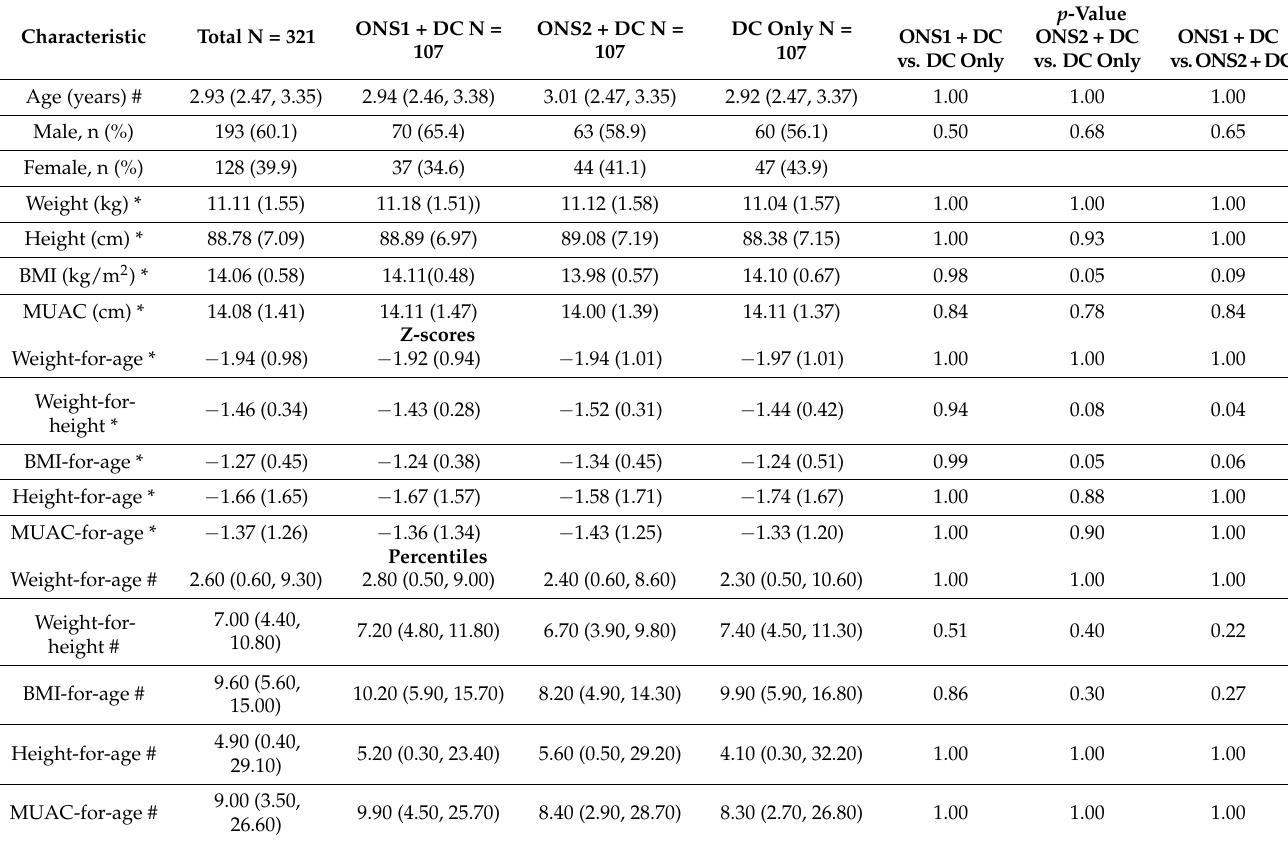
Table 1. Baseline characteristics for study population and treatment